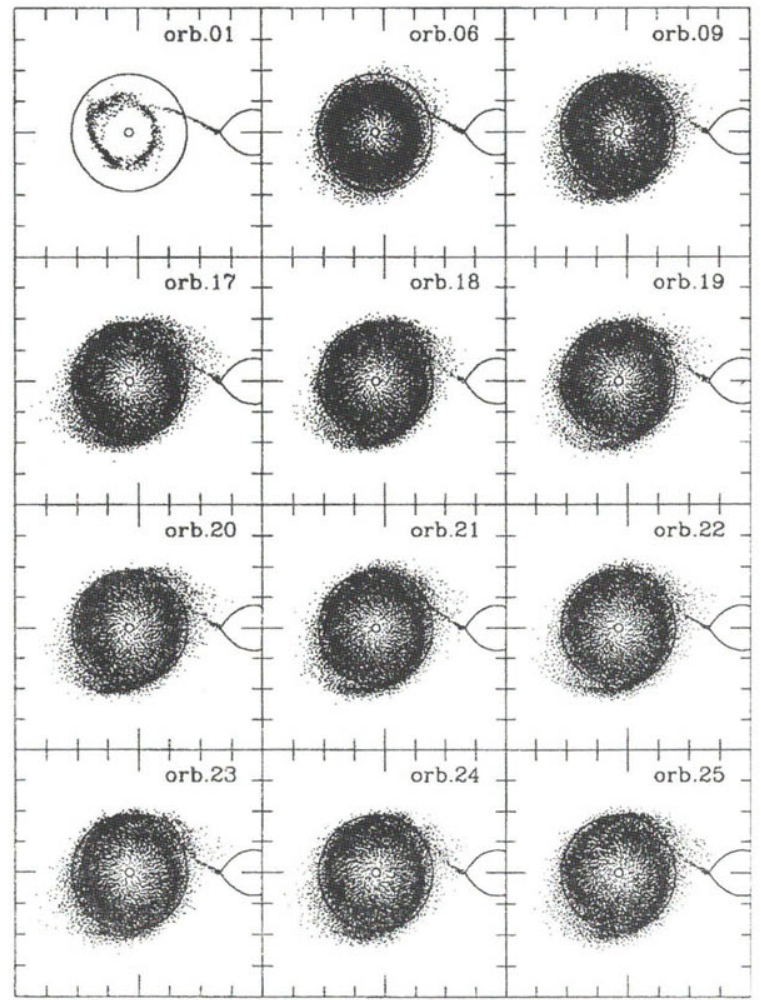
Fig. 1. The projections of all particles onto the orbital plane at the end of selected orbits. The radius of the primary is shown to scale, as is the tidally-distorted surface of the secondary near the C\ point. The large circle in each frame indicates the location of the 3:1 orbital corotation resonance. Note the variable nature of the spiral shocks about a mean